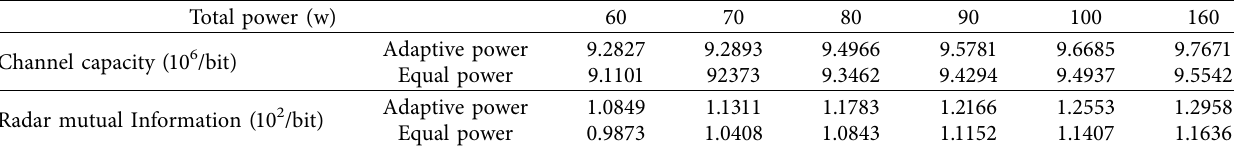
Table 4: Comparison of integrated system performance under different